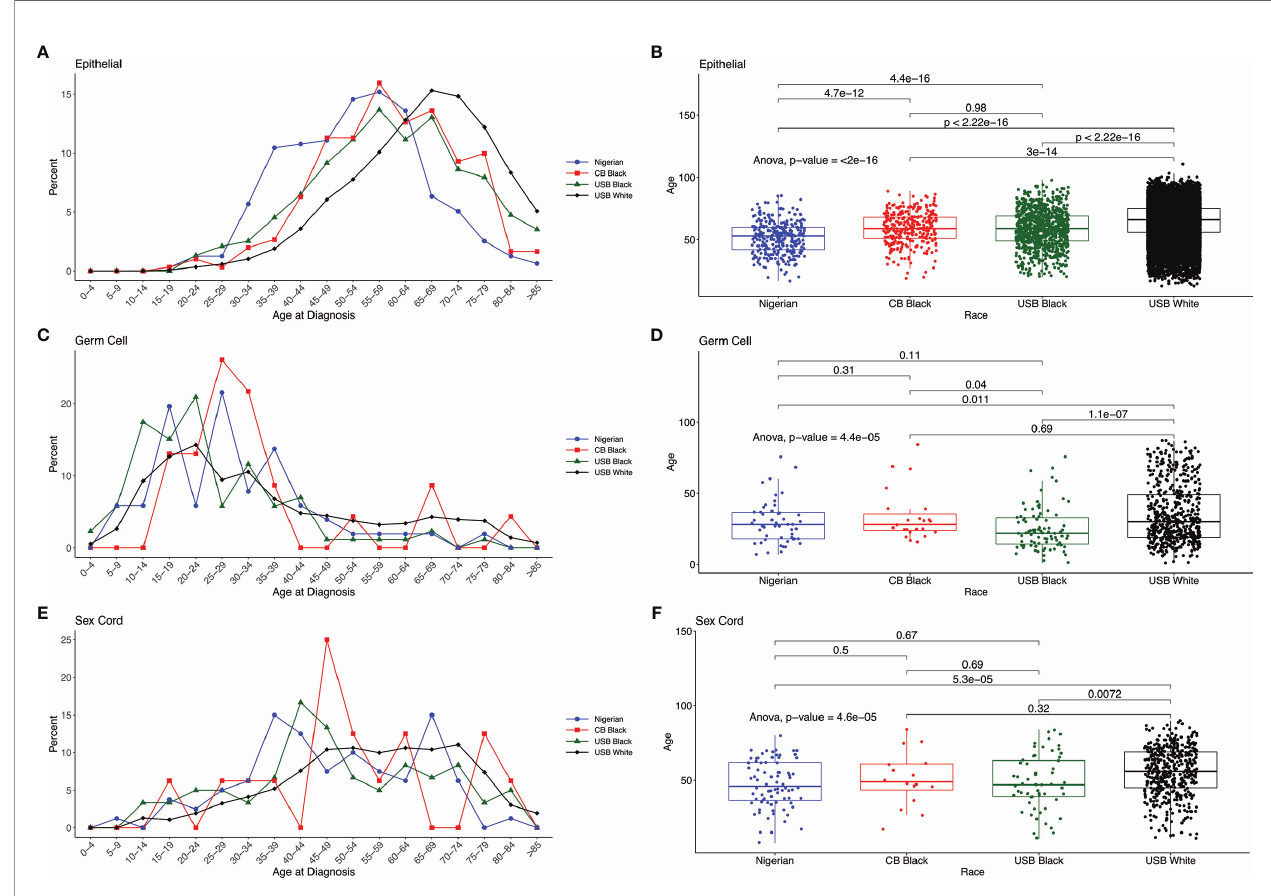
FIGURE 4 | Distribution of cases by age across the comparative groups. (A, C, E) Histograms by histologic type EOC, Germ Cell and Sex Cord Stromal tumors. (B, D, F) ANOVA comparing mean age at cancer diagnosis across different cohorts and histologic